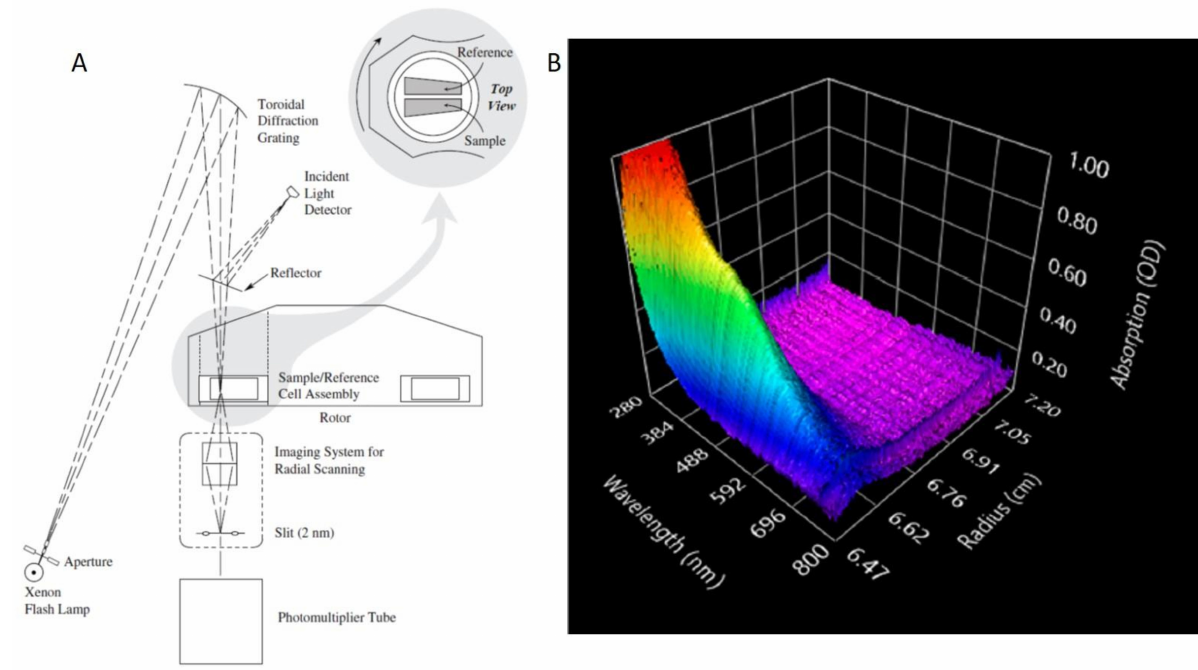
Figure 6. ( A ) Schematic setup of a Beckman CoulterTM Optima TM XL-A Analytical UltraCentrifugation (AUC) instrument (with an UV absorption optic system). Reproduced with permission from [86], Copyright Beckman-Coulter, 1993. ( B ) Typical three-dimensional dataset result for an AUC experiment with a multi-wavelength (MWL) optical